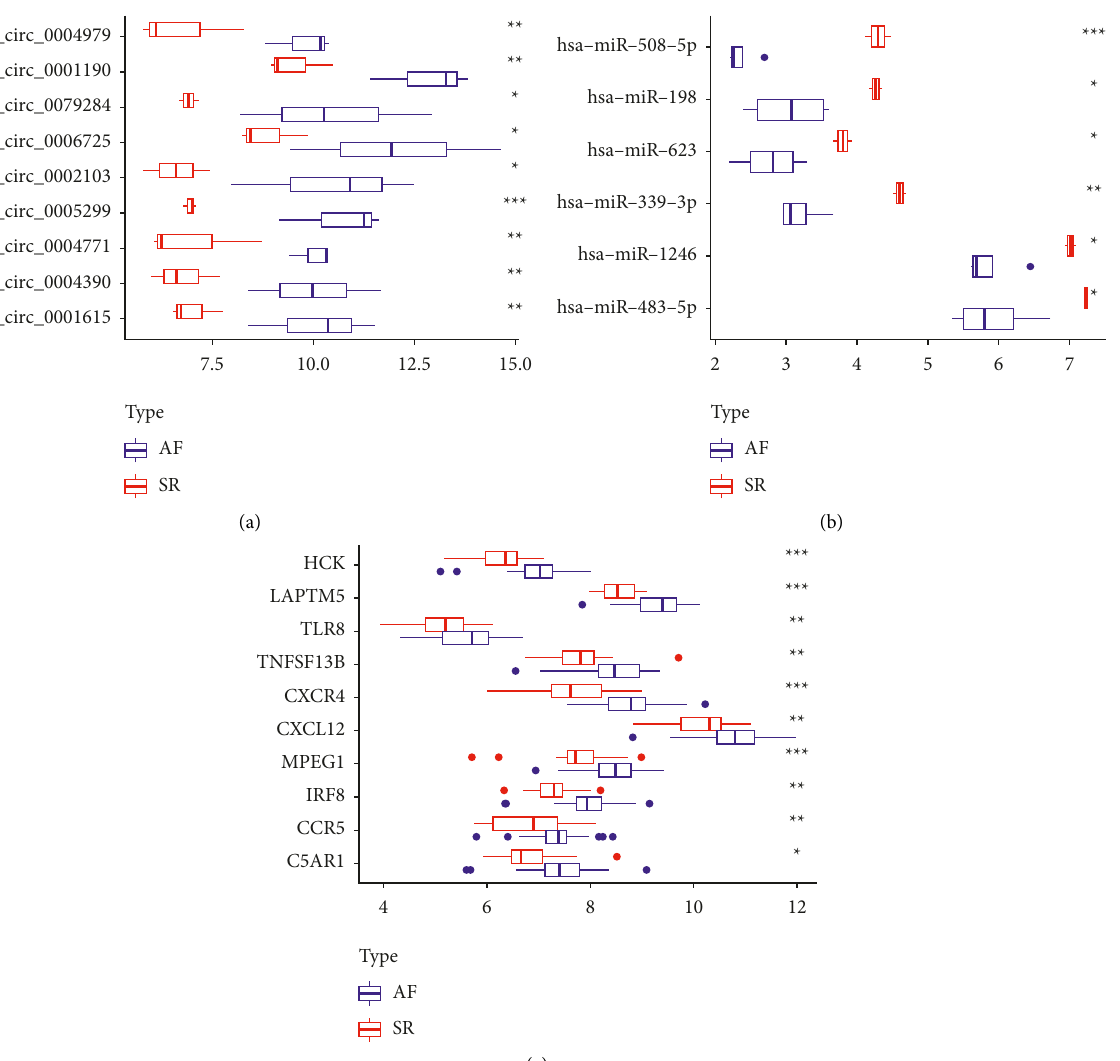
Figure 7: Differential expression of circRNAs (a), miRNAs (b), and mRNAs (c) in their microarray data sets in the circRNA-miRNA-hub gene